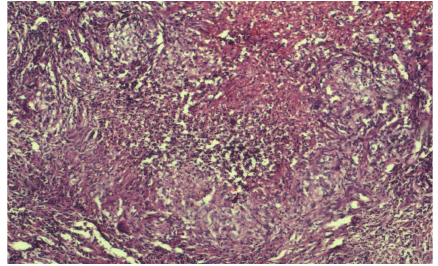
Figure 2: Photomicrograph showing epitheloid cell granulomas with central necrosis (H&E, 100X).